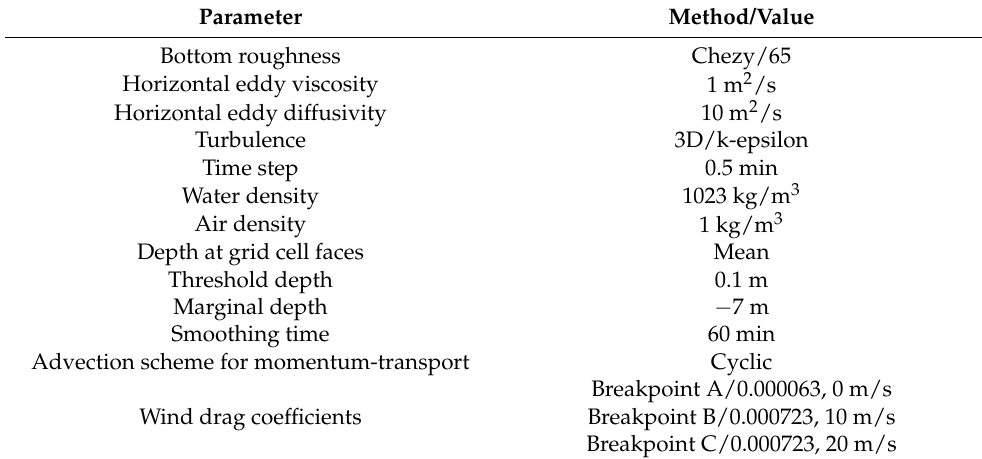
Table 1. Tuned parameters of Delft3D